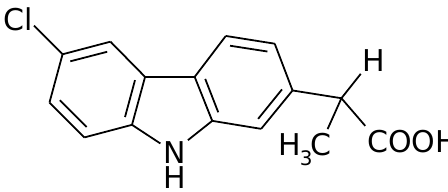
Figure 1. The chemical structure of carprofen.